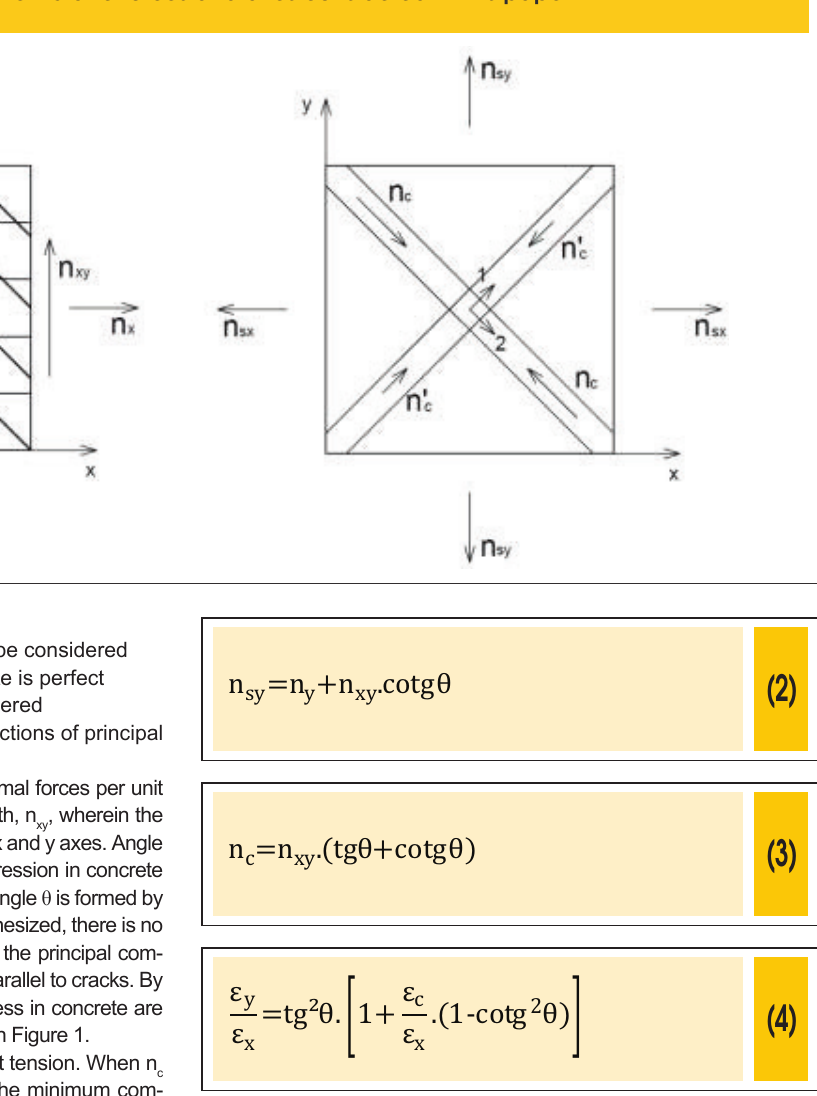
Figure 1 – Positive membrane forces and axes considered in this